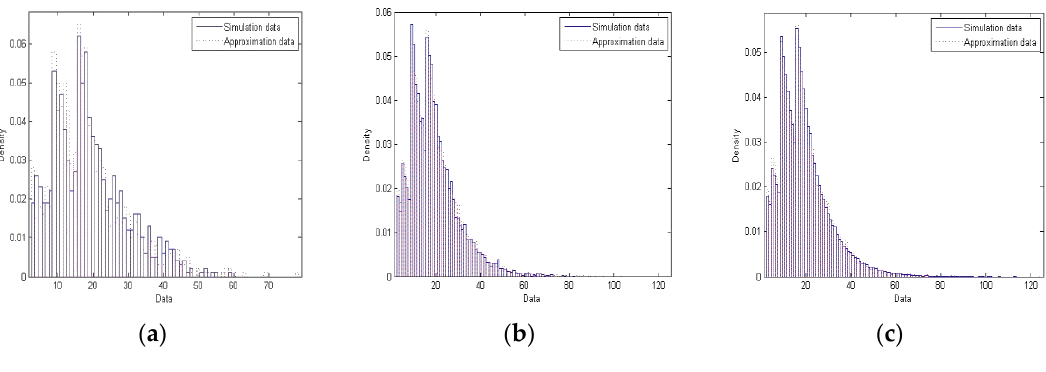
Figure 2. Probability histograms for networks with Table 3. ( a ) 1000 nodes; ( b ) 10,000 nodes; ( c ) 100,000 nodes.